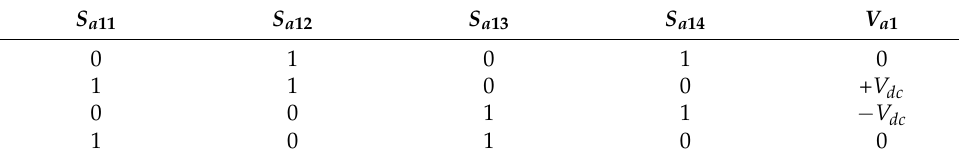
Table 1. Switching sequence and output